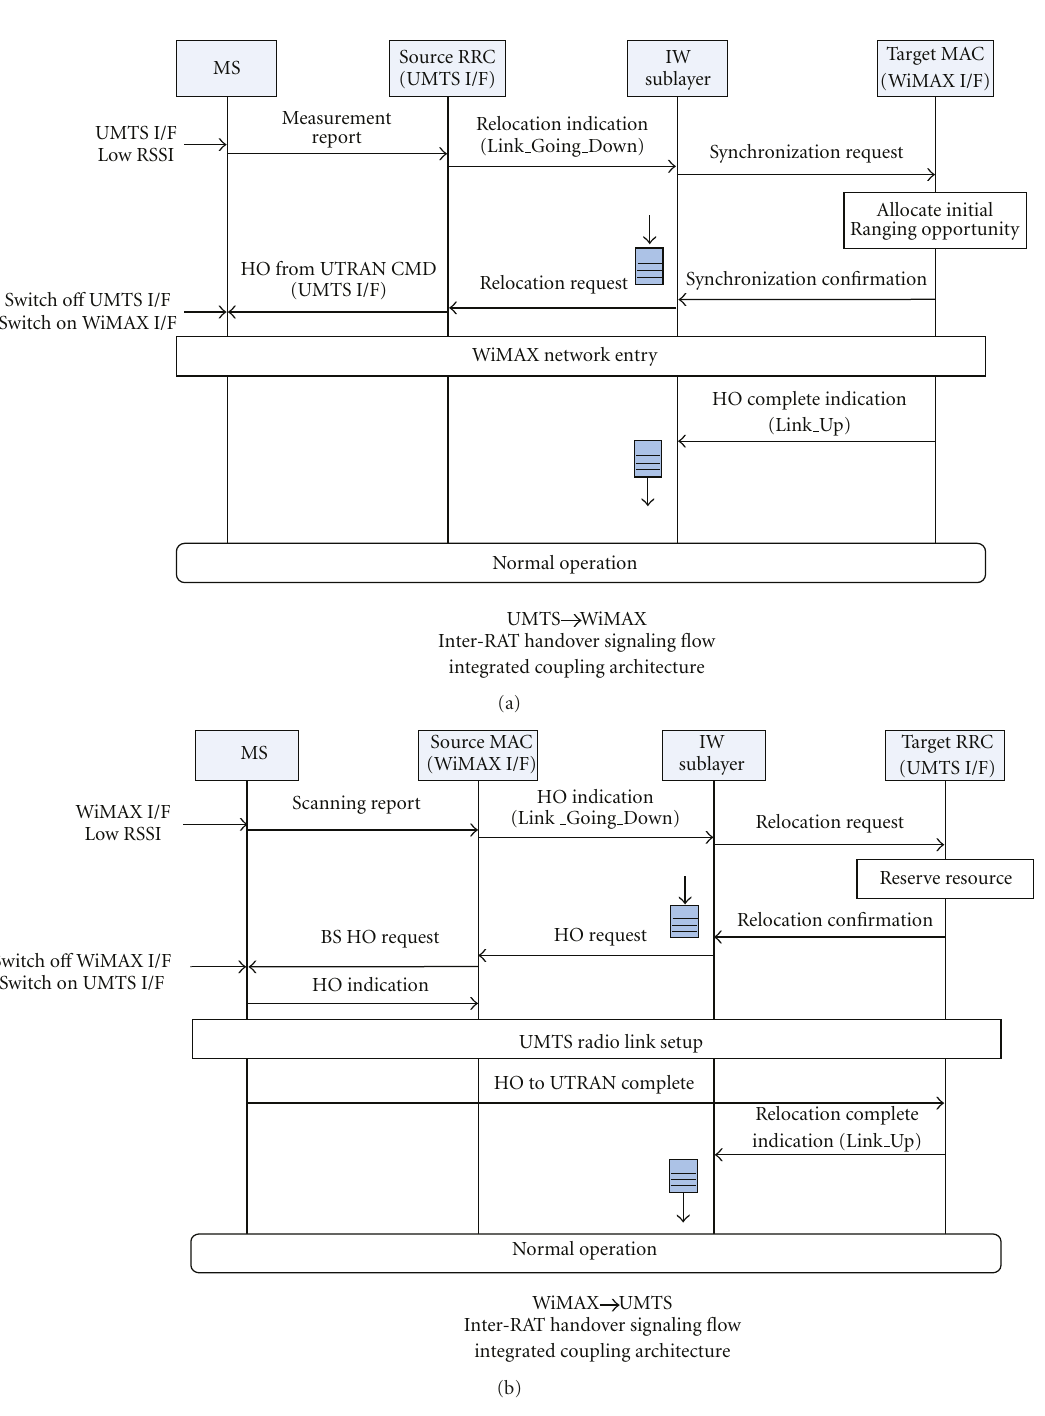
among three kinds of context transfer schemes: R-LLC, SDU Reconstruction, and IW